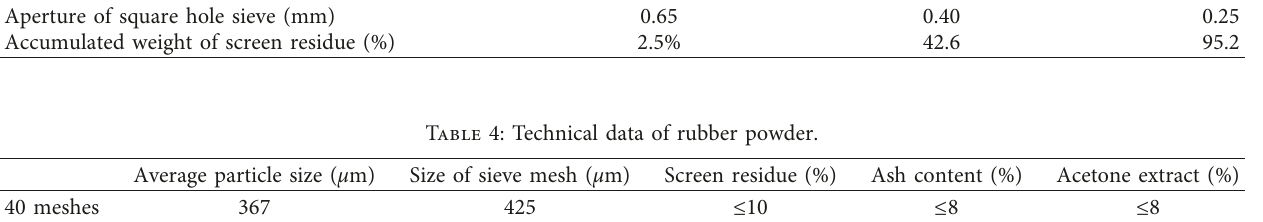
Table 3: Technical data of particle size of China ISO standard sand.